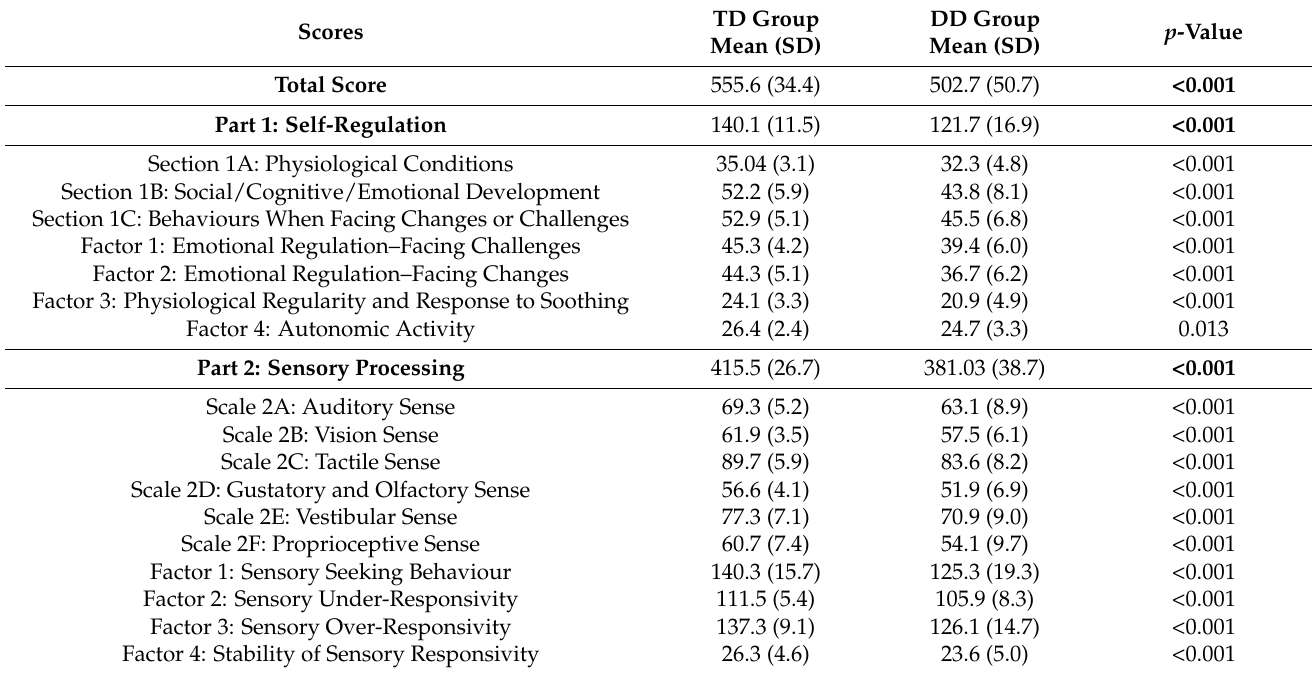
Table 4. Comparison of the scores of SPSRC-IT between TD and DD